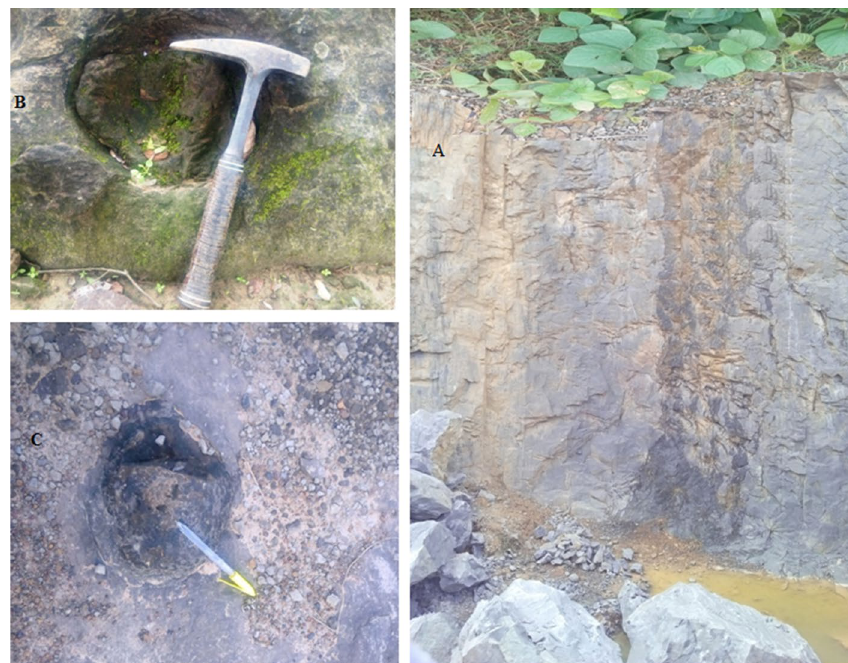
Fig. 13 Bedrock: a ) mine pit around Odomoke area 1, b minor solution cavity on the calcareous sandstone noodle around Ishieke area, c solution cavity around Ugbonga